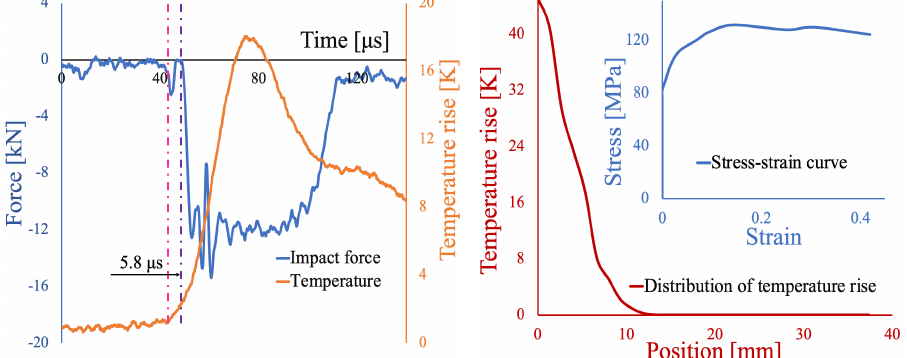
Fig. 3. The time histories of the impact force and Fig. 4. The stress-strain curve and distribution temperature rise. of temperature rise at 76 μ s of the